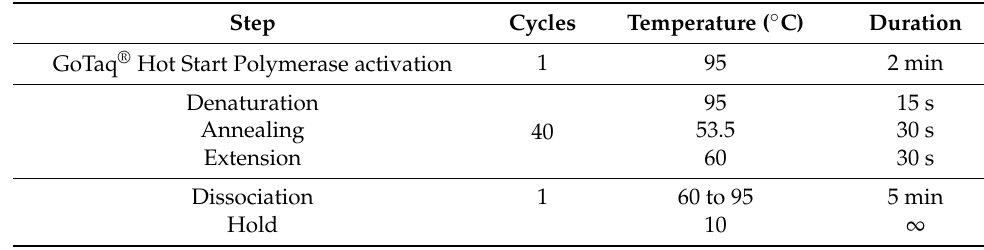
Table 4. Cycling conditions for